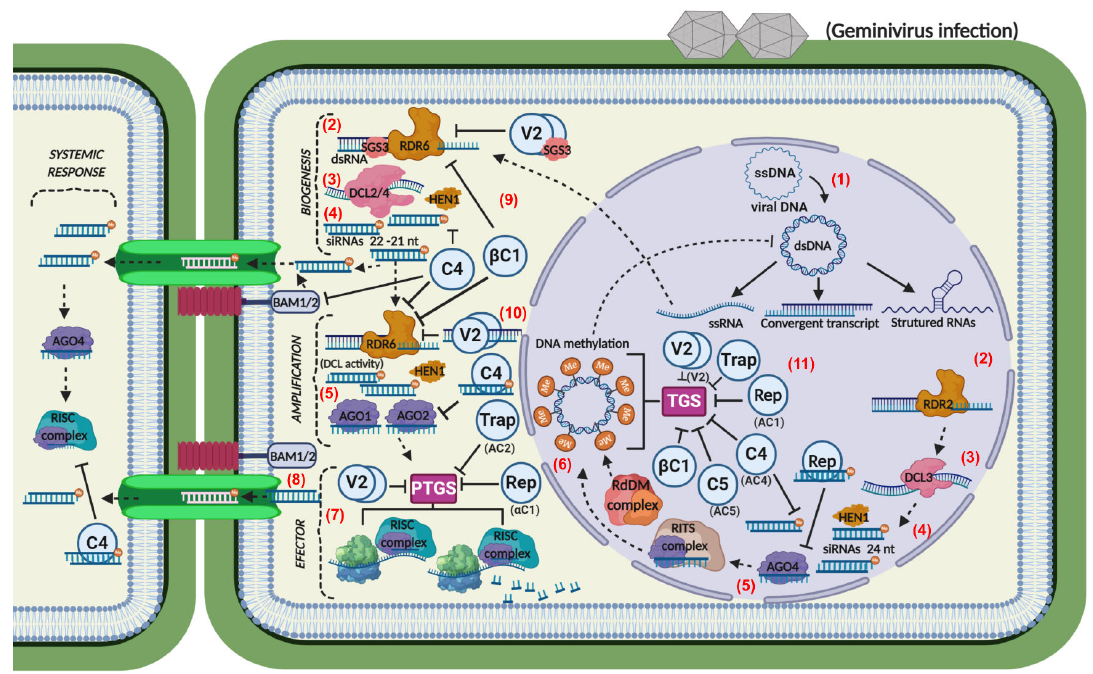
Figure 2. Geminivirus-induced RNA silencing and viral suppressors. Geminivirus particles are delivered into the cytoplasm, where they are uncoated and CP-bound viral ssDNA complexes are imported into the nucleus. (1) In the nucleus, the viral ssDNA is converted into dsDNA, the replicative form. (2) Then, viral ssRNAs are synthesized and are recognized by the RNA-silencing machinery, initiating the biogenesis phase by converting ssRNA to dsRNA via RDR2 (RNA-dependent RNA polymerase 2 in the nucleus) or RDR6 (in the cytoplasm) with the help of suppressor gene silencing 3 (SGS3), which stabilizes the substrates for (3) dicer (DCL)-mediated processing into 21-, 22-, or 24-nt siRNAs (virus-derived small interfering RNA; vsiRNA). (4) HUA Enhancer 1 (HEN1)-methylated siRNAs are then amplified by RDR1 or RDR6 enhancing